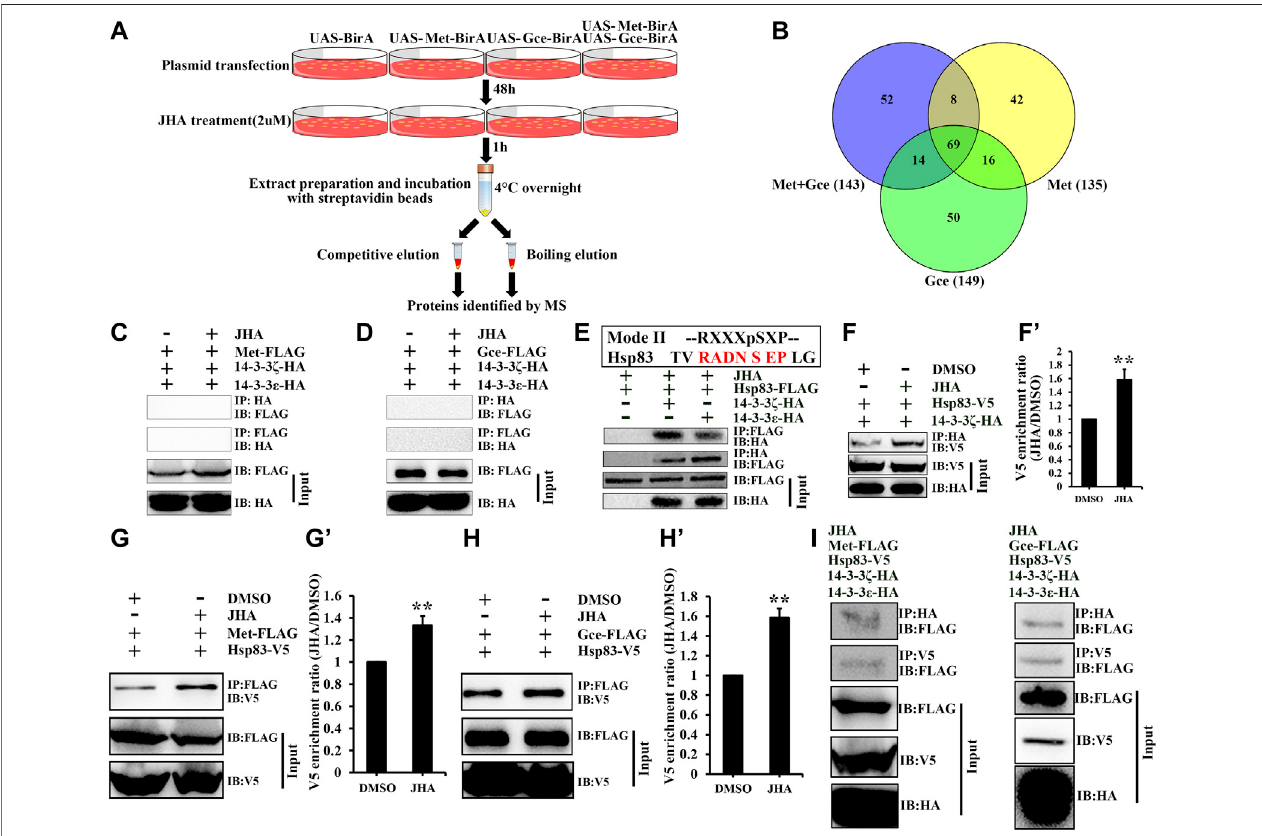
FIGURE 6 | Hsp83 bridges an interactionbetween Met/Gceand 14-3-3 proteins. (A) A fl owchart showingthe strategyfor puri fi cation ofpotential bindingproteins of Met/Gce from Drosophila Kc cells. (B) Venn diagram showing the numbers of binding protein for Met, Gce or both of them in the presence of JHA. A total of 69 conjugates of Met/Gce were identi fi ed in all data sets. See detailed information of the identi fi ed proteins in Supplementary Table S5 . (C – E) 14-3-3 proteins physically interact with Hsp83 (E) but not Met (C) and Gce (D) , as determined by Co-IP. (F – H ’ ) JH promotes Hsp83 binding activity with 14-3-3 proteins or Met/Gce. Quali fi cationofV5 (F ’ ,G ’ ,H ’ ) ofthewesternblottingresultsin (F,G,H) usingtubulinasacontrol.** p < 0.01(Student ’ st-test). (I) Hsp83interacteswithMet/Gceand14-3-3 toformatripolymercomplexinthepresenceofJHA.Celllysatesweresubjectedtoimmunoprecipitation(IP)withananti-FLAG (C,D,E,G,H) ,ananti-HA (F,I) andananti- V5 (I) , antibody, respectively. The interacting proteins were detected on immunoblot (IB).